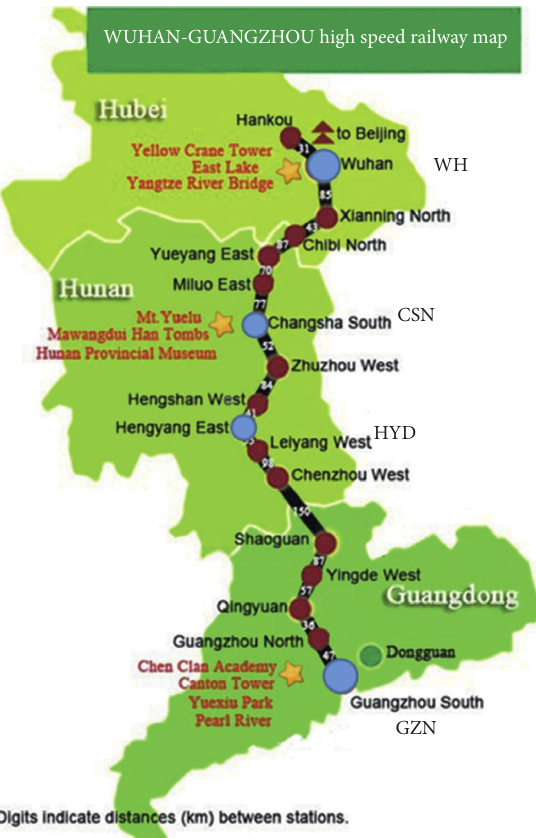
Figure 8: The first long mileage HSR in China: Wuhan- Guangzhounan